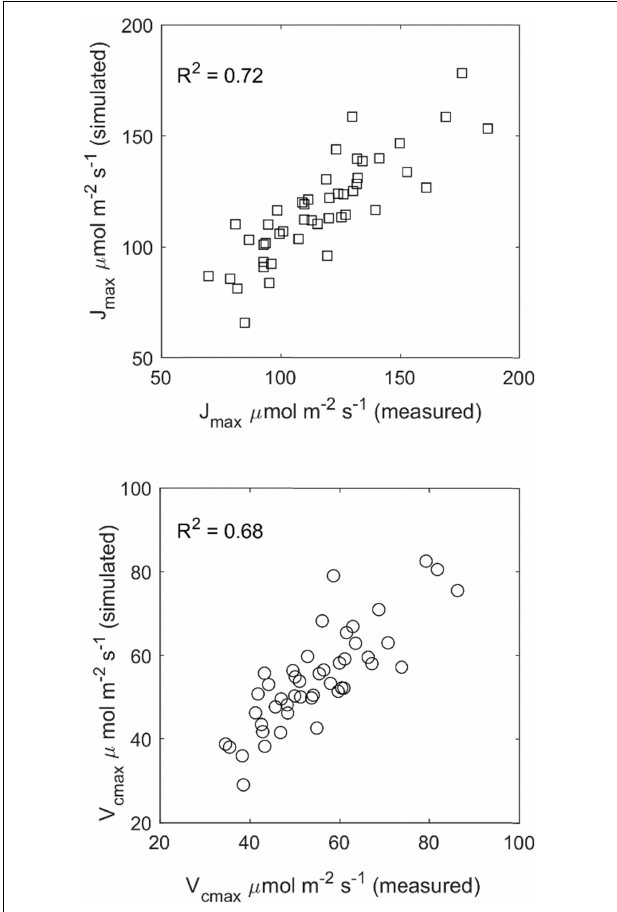
FIGURE 6 | Comparison of predicted vs. measured maximum rates of carboxylation ( V cmax ) and electron transport ( J max ) at different canopy depths over 2 months in a tomato canopy. n = 46. Refer to Table 2 for more details.